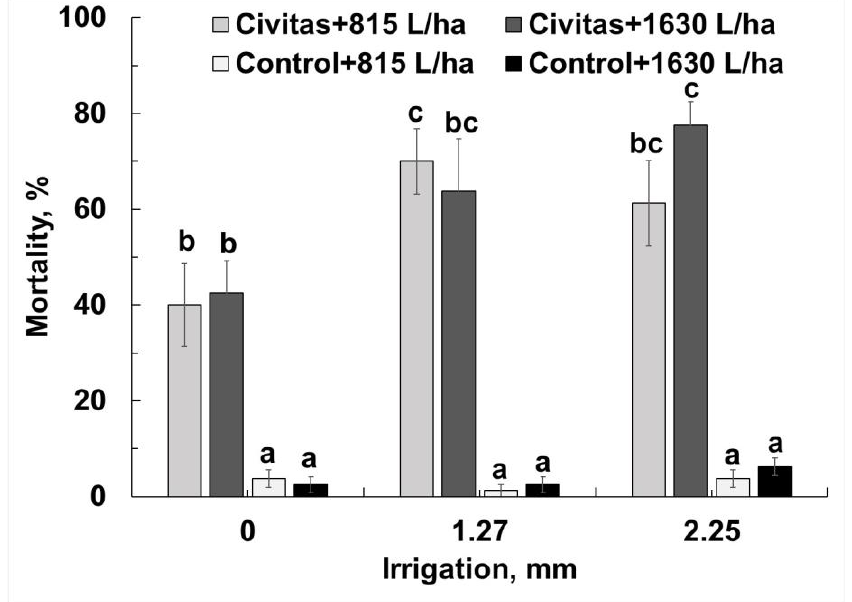
Figure 6. Effect of post treatment irrigation on Civitas (51.4 L/ha) efficacy against Listronotus maculicollis adults (data combined across different carrier volumes). Means marked with the same letter do not differ statistically within each evaluation time. Carrier volume (815 or 1630 L/ha) had no effect on ABW mortality.